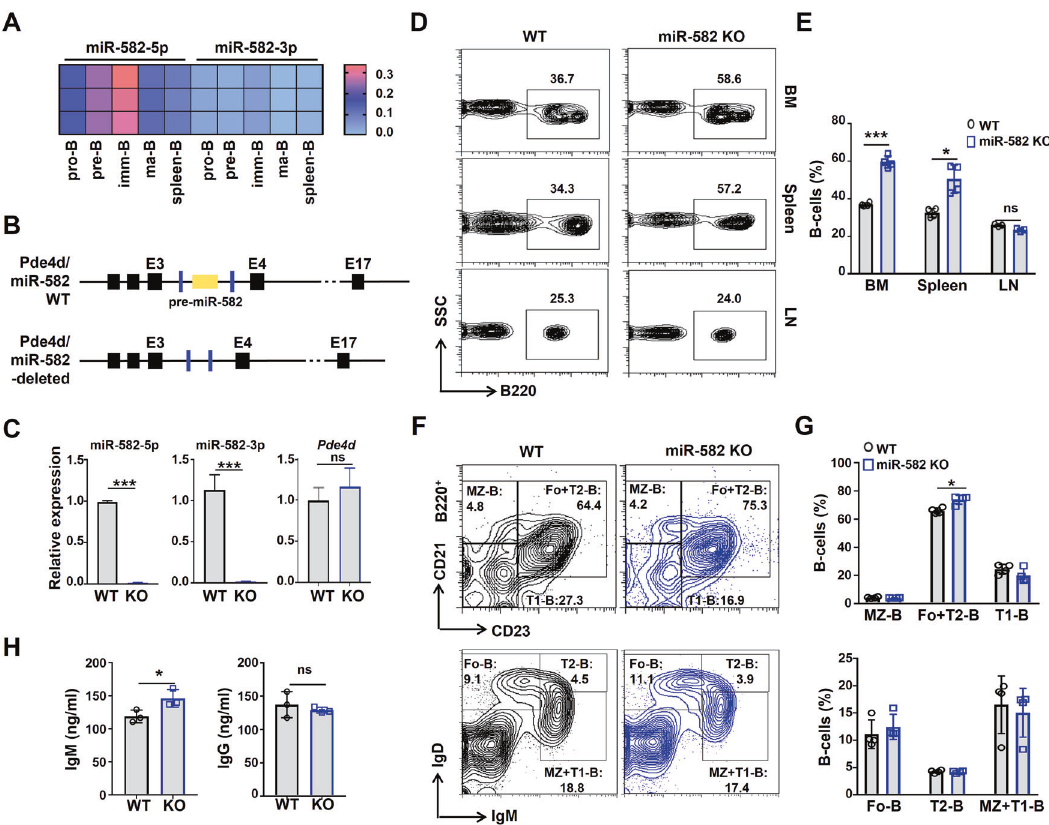
which is accommodated in the third intron of Pde4d gene, in mice. Black boxes and lines indicate exons and introns of the murine Pde4d gene, respectively. pre-miR-582 gene is represented with a yellow box, and the blue boxes indicate the position of primers for genotyping. C Expression of miR-582-5p, miR-582-3p, and Pde4d gene in total BM B cells from wild type and miR-582-deleted mice was determined by qRT- PCR, with U6 and β -actin as reference controls for miRNAs and Pde4d , respectively ( n = 3). D , E Single cell suspensions from BM, spleen, and lymph nodes (LN) from miR-582 de fi cient and control mice were analyzed by fl ow cytometry ( D ), and the percentage of B220 + B cells in each organ were quantitatively compared ( E ) ( n = 4). F , G Spleen cells from adult miR-582 de fi cient mice and normal littermates were stained as indicated and analyzed by FACS ( F ). Marginal zone (MZ-) B cells (CD45 + B220 + CD21 high CD23 − ), follicular (Fo-) B cells (CD45 + IgD + IgM − ), transitional 1 B cells (CD45 + B220 + CD21 low/ − CD23 − ), transitional 2 B cells (CD45 + IgD high IgM + ), Fo + T2-B cells (CD45 + B220 + CD21 + CD23 + ),